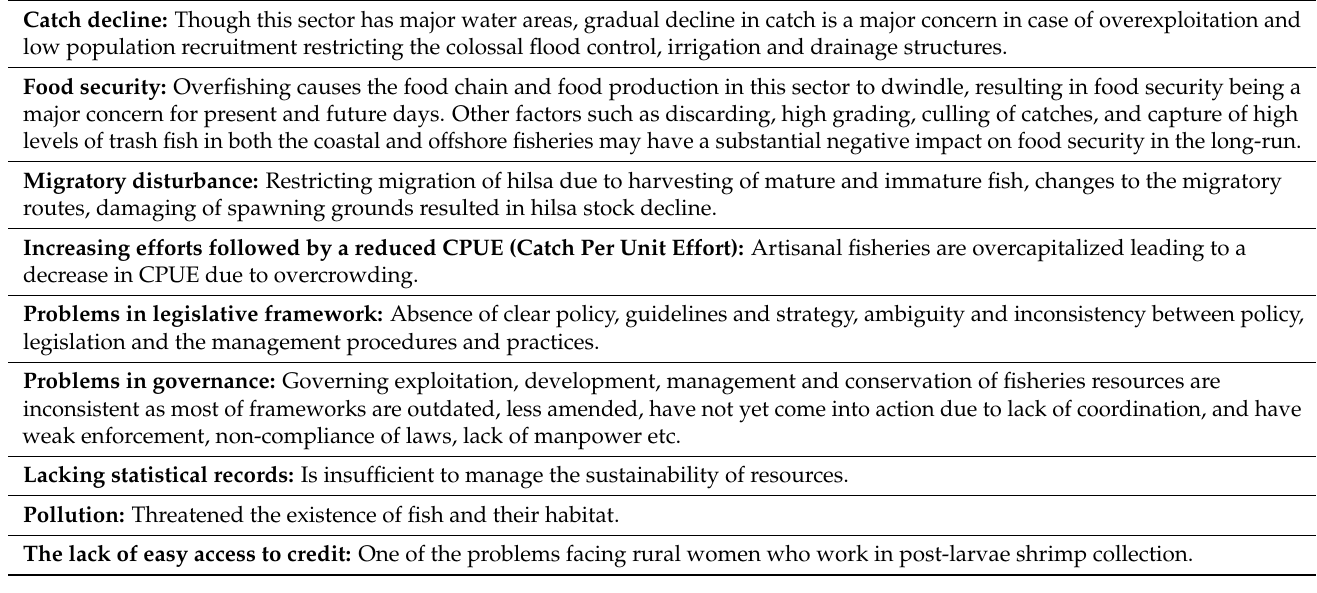
Table 1. Constraints of the Bangladesh fisheries sector as identified by FAO